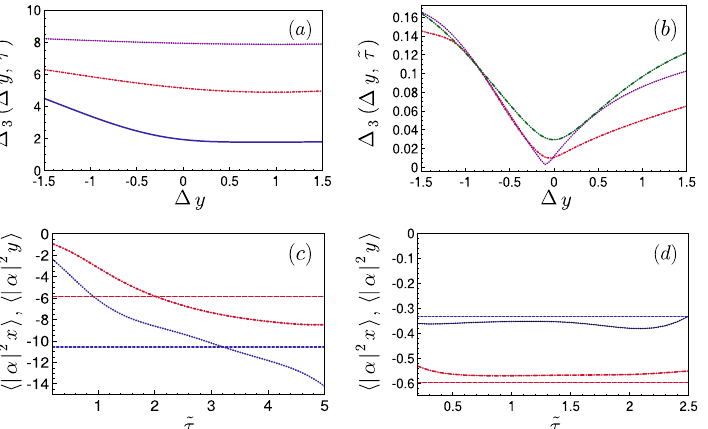
Figure 2. Distance of the 3rd-order moments to their target in a shortcut to quantum synchronization. (a,b): Mismatch � 3 (� y , τ) [Eq. (5)] of the final 3rd-order moments with respect to their targets as a function of the offset (cid:31) y of the intermediate point ( x m , y m + � y ) for ( a ) the weakly and ( b ) the strongly nonlinear regime. We have taken the shortcut durations ˜ τ = 2 (solid blue line, ( a )), ˜ τ = 1 (red dash-dotted line, (a,b)), ˜ τ = 0.5 (purple dotted line ( a , b )) and ˜ τ = 0.25 (green dash-double-dotted line, ( b )). ( c , d ): Third-order moments �| α | 2 x � τ (red dash-dotted) and �| α | 2 y � τ (blue dotted) as a function of the shortcut duration ˜ τ for the ( c ) weakly and ( d ) strongly nonlinear regimes. In ( c , d ) we have taken shortcuts corresponding to (cid:31) y = 0 . Horizontal lines represent their respective stationary values �| α | 2 x � ∞ (red dashed) �| α | 2 y � ∞ (blue dashed) under a constant drive ˜ ε = 1, ˜ ε = 0. See Supplementary for details on the shortcut 1 2